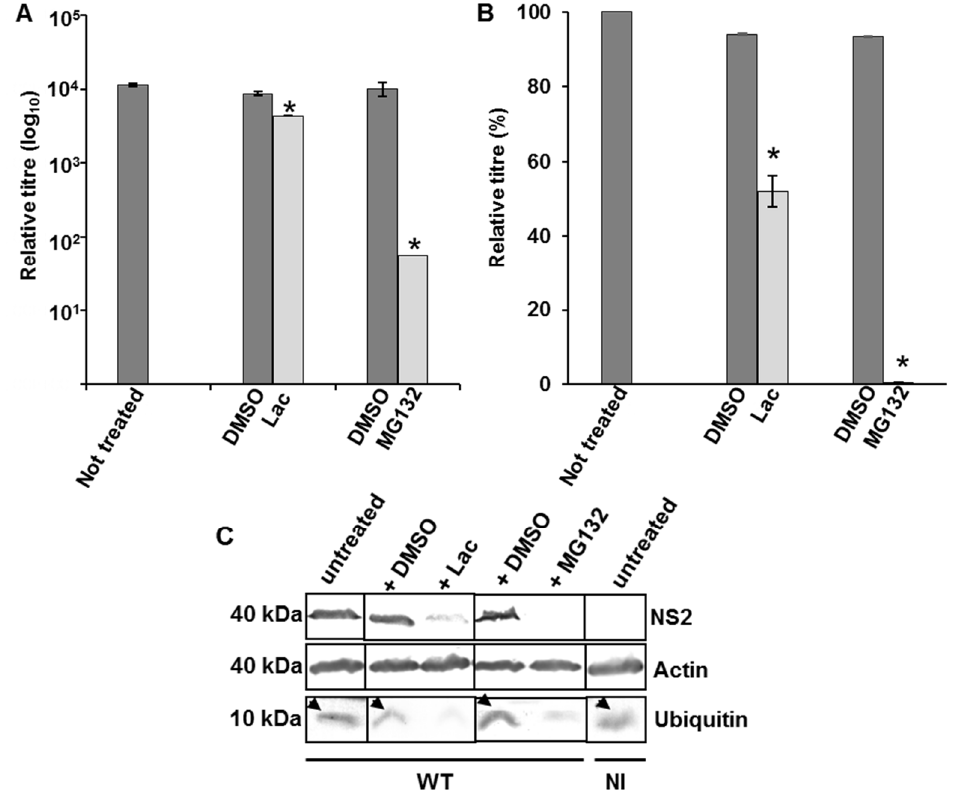
Figure 3. Influence of proteosome inhibitors on BTV growth in PT cells. ( A , B ) Cells infected with WT BTV at 0.1 MOI were incubated with MG132 or lactacystin. The total ( A ) and relative ( B ) titres were assessed at 12 h pi. The plaque assays were done in triplicate and bars represent standard error. Significant difference in the virus titres were designated by the asterisk ( * ). Presence or absence of diluent DMSO and inhibitors have been indicated below the graph; ( C ) Expression of NS2, actin and ubiquitin in treated and infected PT cells. The cells were treated similar to A. Lysates were analyzed by SDS-PAGE and Western blotting. Molecular masses and proteins are indicated on left and right, respectively. Arrows represent presence of ubiquitin in untreated cells. Presence or absence of diluent DMSO and inhibitors has been indicated on the top of the panel. NI signified uninfected